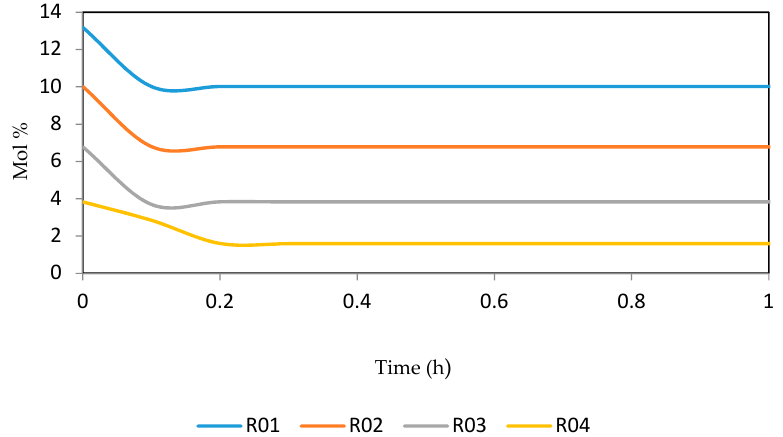
Figure 22. Dynamic behaviour of N 7 in the four reactors.